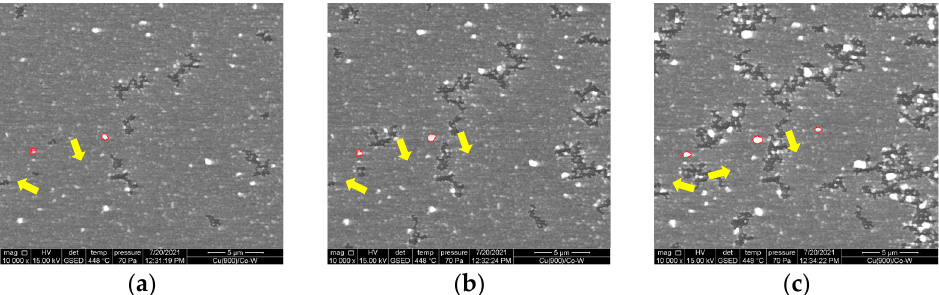
Figure 2. Dewetting progression at 450 °C of a Cu film with a Co-W substrate during a 3 min time-lapse, heated at 10 °C/min, with ( b , c ) being captured 1 and 3 min after ( a ), respectively. Yellow arrows and red outlines indicate abnormally large grains growing some distance from the developing dewetting front.